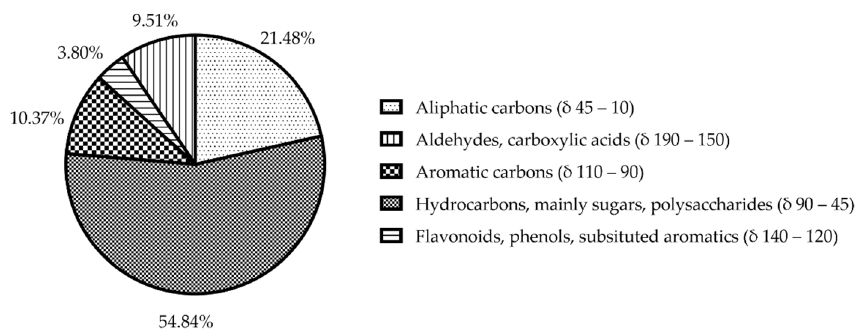
Figure 5. Pie diagram showcasing the signals ratio of different functional groups calculated from E. foeminea 13 C solid-State NMR spectrum.